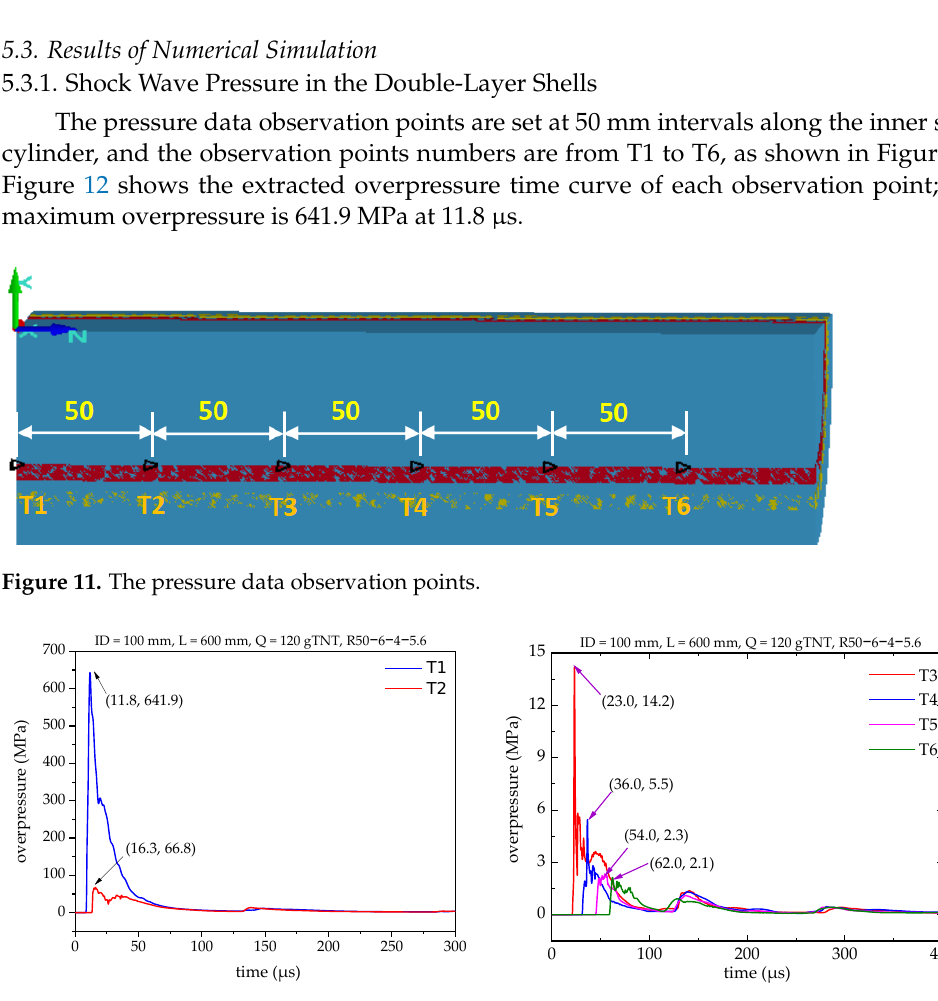
Figure 12. The overpressure curves of T1 to T6.